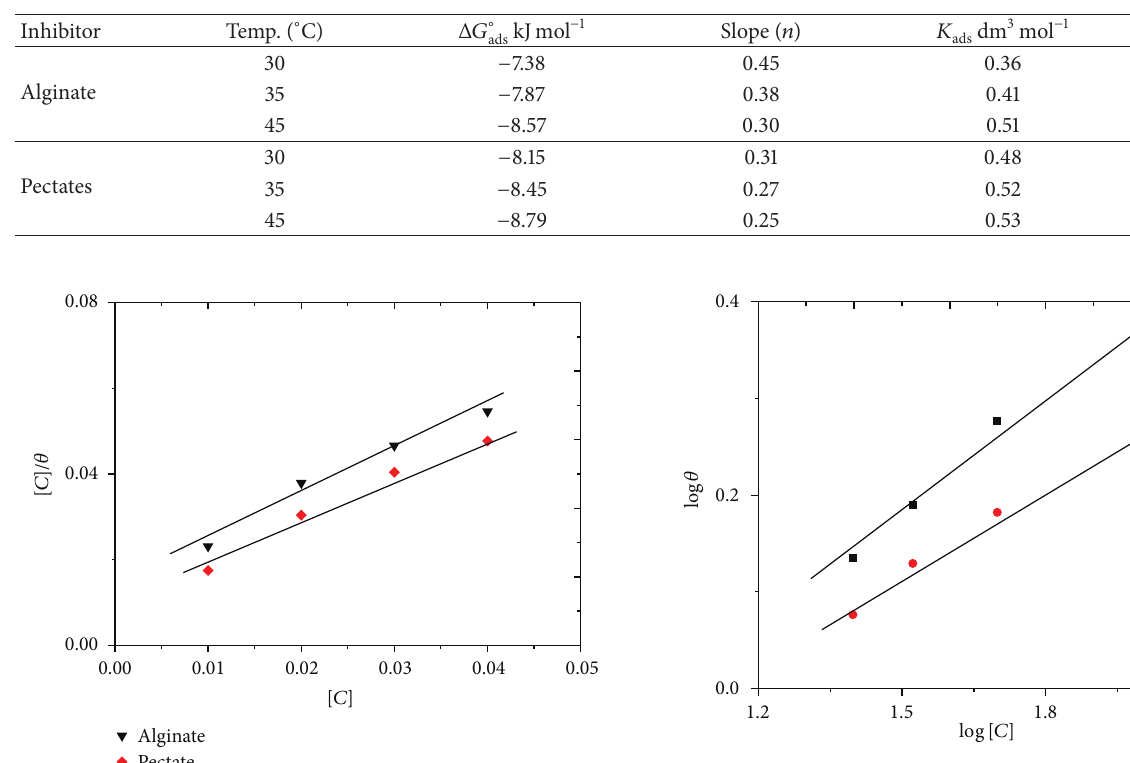
Table 6: Some kinetic parameters from Freundlich isotherm model for corrosion of Al in alkaline media. [OH − ] = 4.0 and I = 4.0mol dm − 3 .